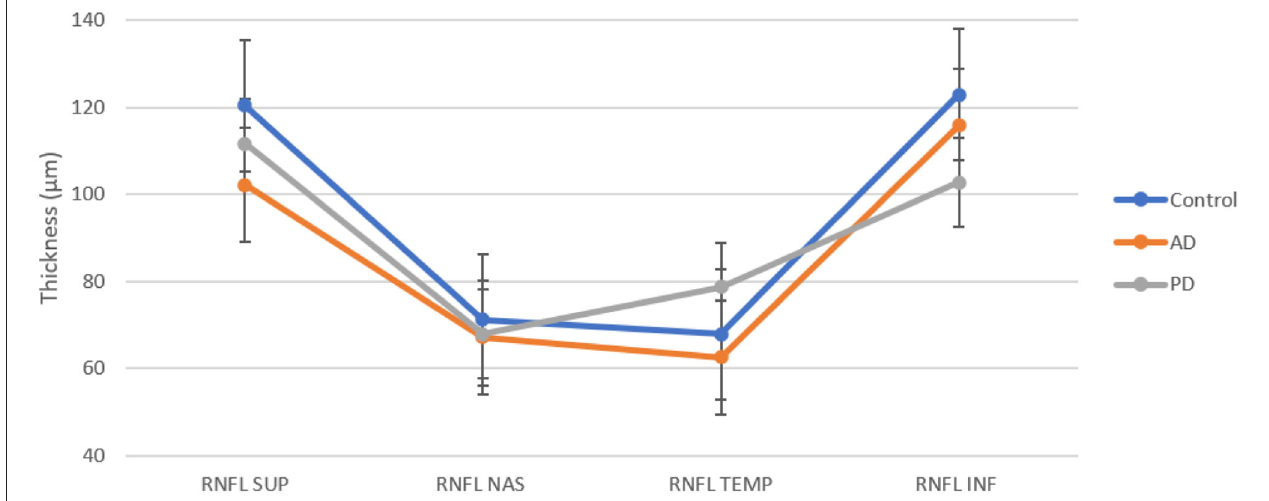
FIGURE 1 | RNFL thickness in superior, nasal, temporal, and inferior sectors for each group.